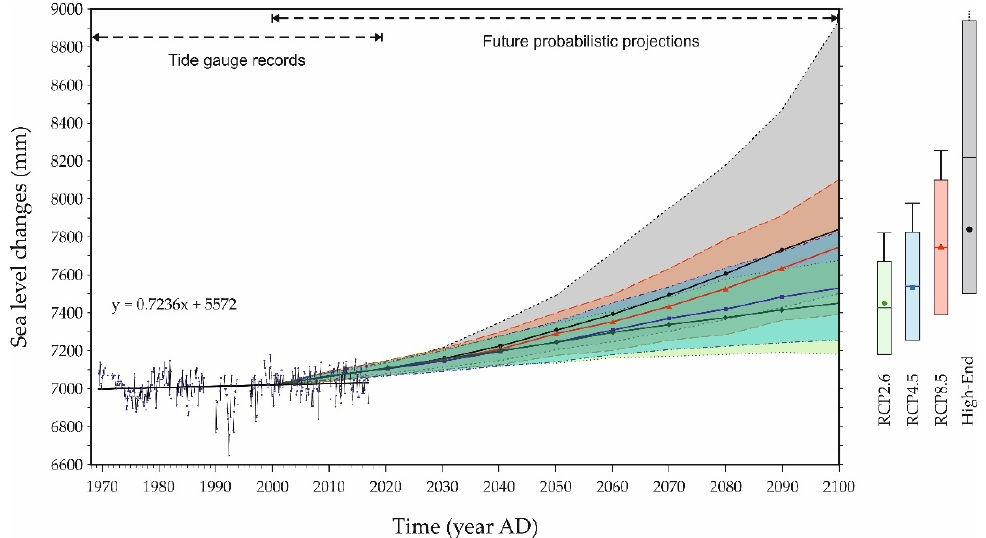
Figure 2. Monthly sea level data (blue dots) together with their linear trend (black solid line with its equation) are shown for the period 1969–2016, obtained from the tide gauge station of Rhodes Island. The local projections of the range of the mean SLR (with the 95% confidence limits) over the next decades (up to the end of the 21st century) for the RCP2.6 (green-shaded area; SLR rate of 4.4 mm y − 1 ), RCP4.5 (blue-shaded area; SLR rate of 5.4 mm y − 1 ), RCP8.5 (red-shaded area; SLR rate of 8.1 mm y − 1 ) and High-End (gray-shaded area; SLR rate of 9.3 mm y − 1 ) scenarios are also displayed, derived from the probabilistic approach of Jevrejeva et al. [70] and Jackson and Jevrejeva [71]. The mean sea level has been adjusted to the revised local reference for Rhodes (tide gauge station ID: 1243).